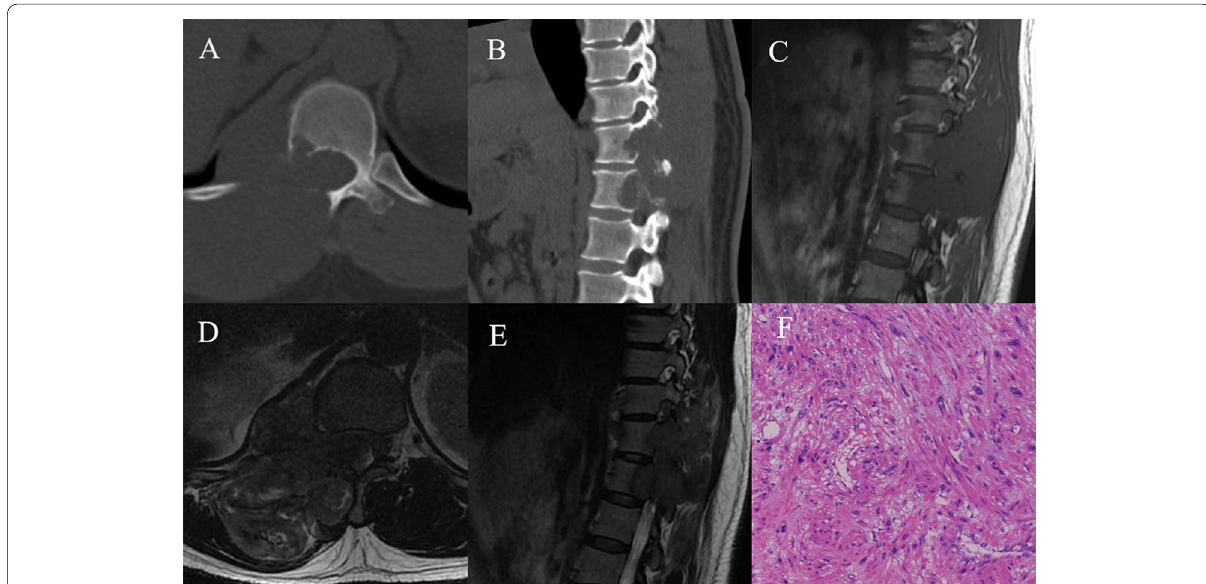
Fig. 2 A 44-year-old female with T11–T12 primary leiomyosarcoma. A Axial computed tomography (CT) bone window showed that the mass destroyed the surrounding bone; B Sagittal CT bone window showed bone destruction of T11–T12 vertebral body and posterior elements, with residual bone trabeculae; C T1 weighted imaging (T1WI) in sagittal view showed an isointense mass; D T2 weighted imaging (T2WI) in axial view showed a lobulated mass with ill-defined border; E T2WI in sagittal view showed an isointense mass; F The interstitial tumor showed diffuse spindle cell hyperplasia with many nuclear fissions (HE; 400) ×